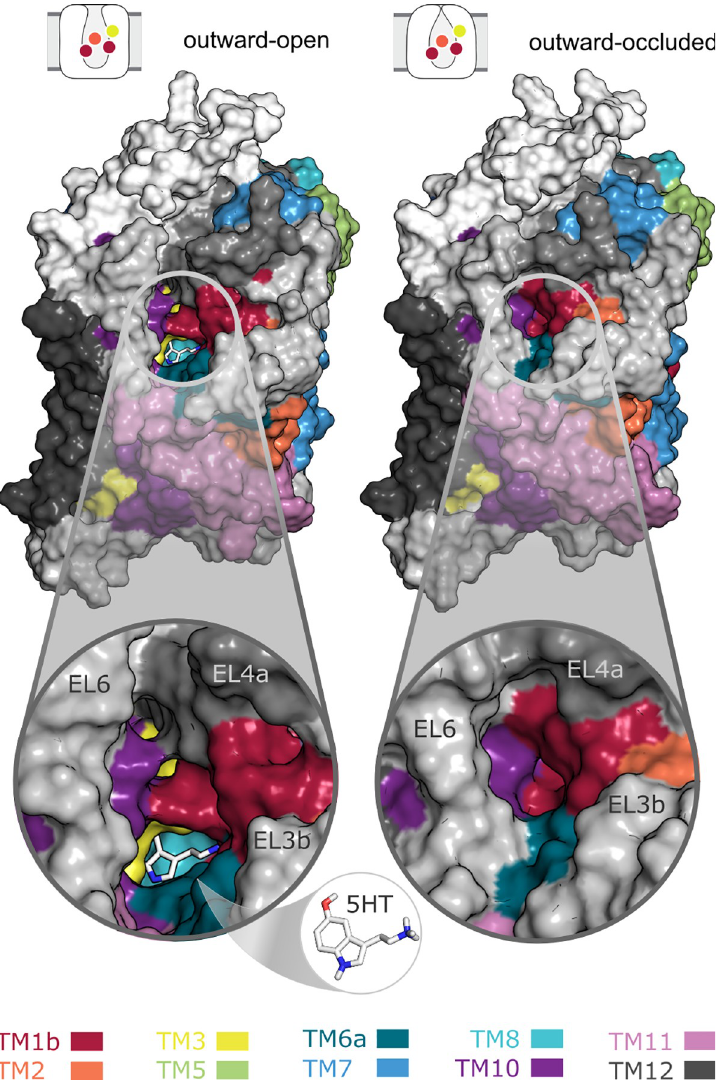
substrate molecule is visible from outside in the outward-open structure, but is covered in the outward-occluded structural model, where TM1b and TM6a bend over and close this same pathway from the synaptic cleft.